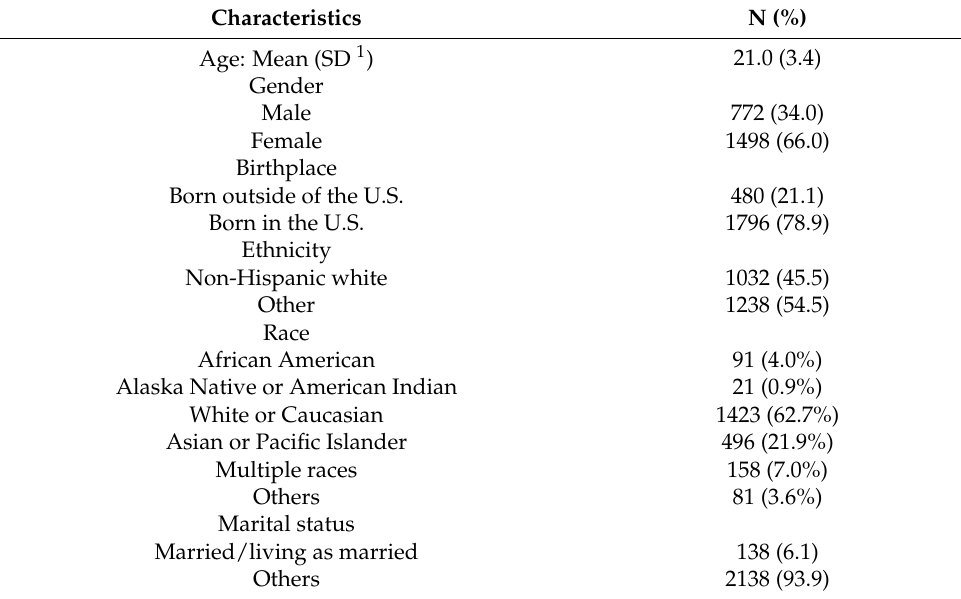
Table 1. Demographic characteristics of college students (N =